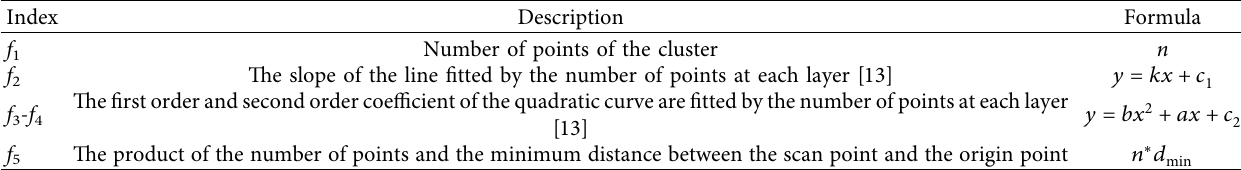
Table 1: Number-of-point-based features.